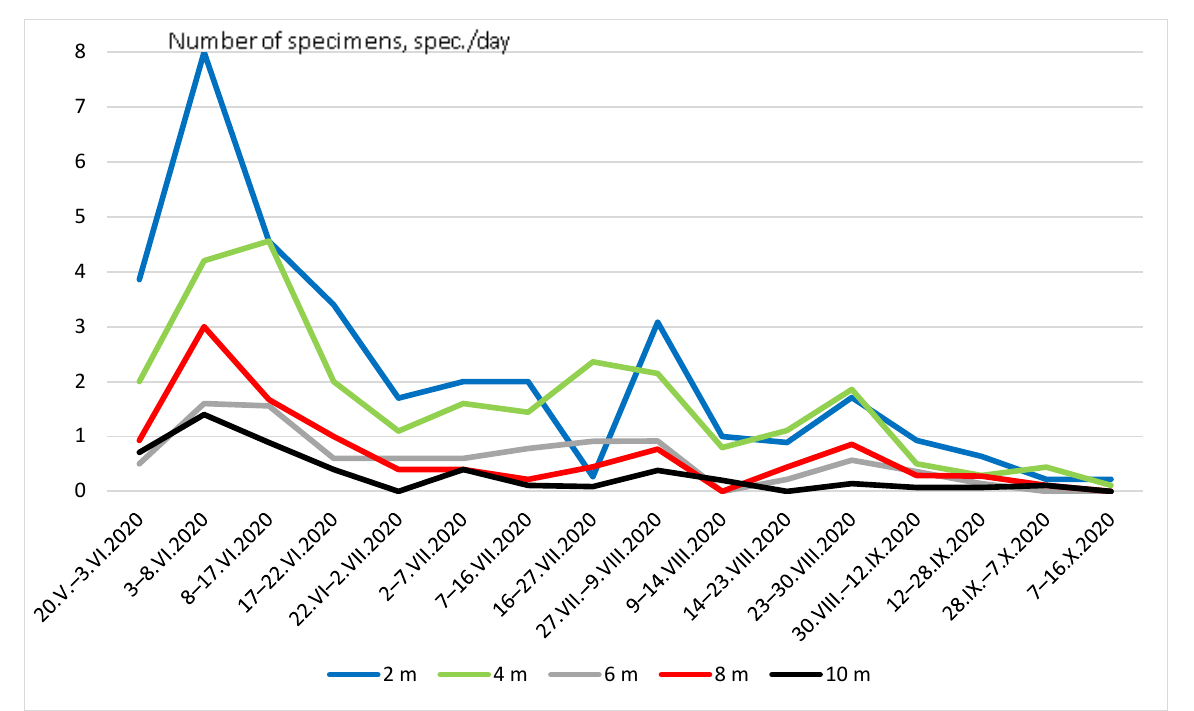
Figure 4. Seasonal dynamics of Coleoptera abundance at different heights.